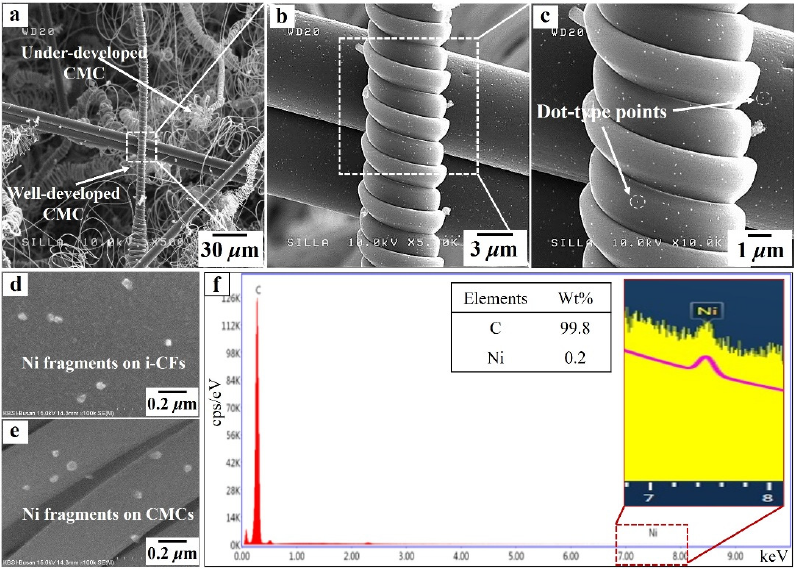
Figure 4. ( a ) FESEM image of sample B, ( b ) magnified FESEM image of Figure 4a, ( c ) magnified FESEM image of Figure 3b, ( d ) high magnification FESEM image of the surface of i-CFs, ( e ) high magnification FESEM image of the surface of carbon microcoils (CMCs), and ( f ) energy dispersive X-ray spectroscopy (EDS) histogram of the surface of the CMCs in Figure 4e.